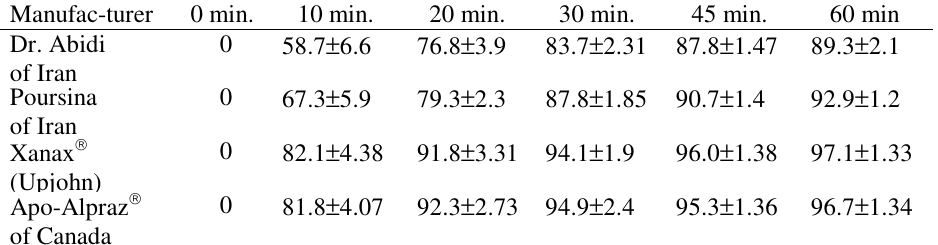
Table 8 . Average of the percentage released of active ingredient of alprazolam tablets at various